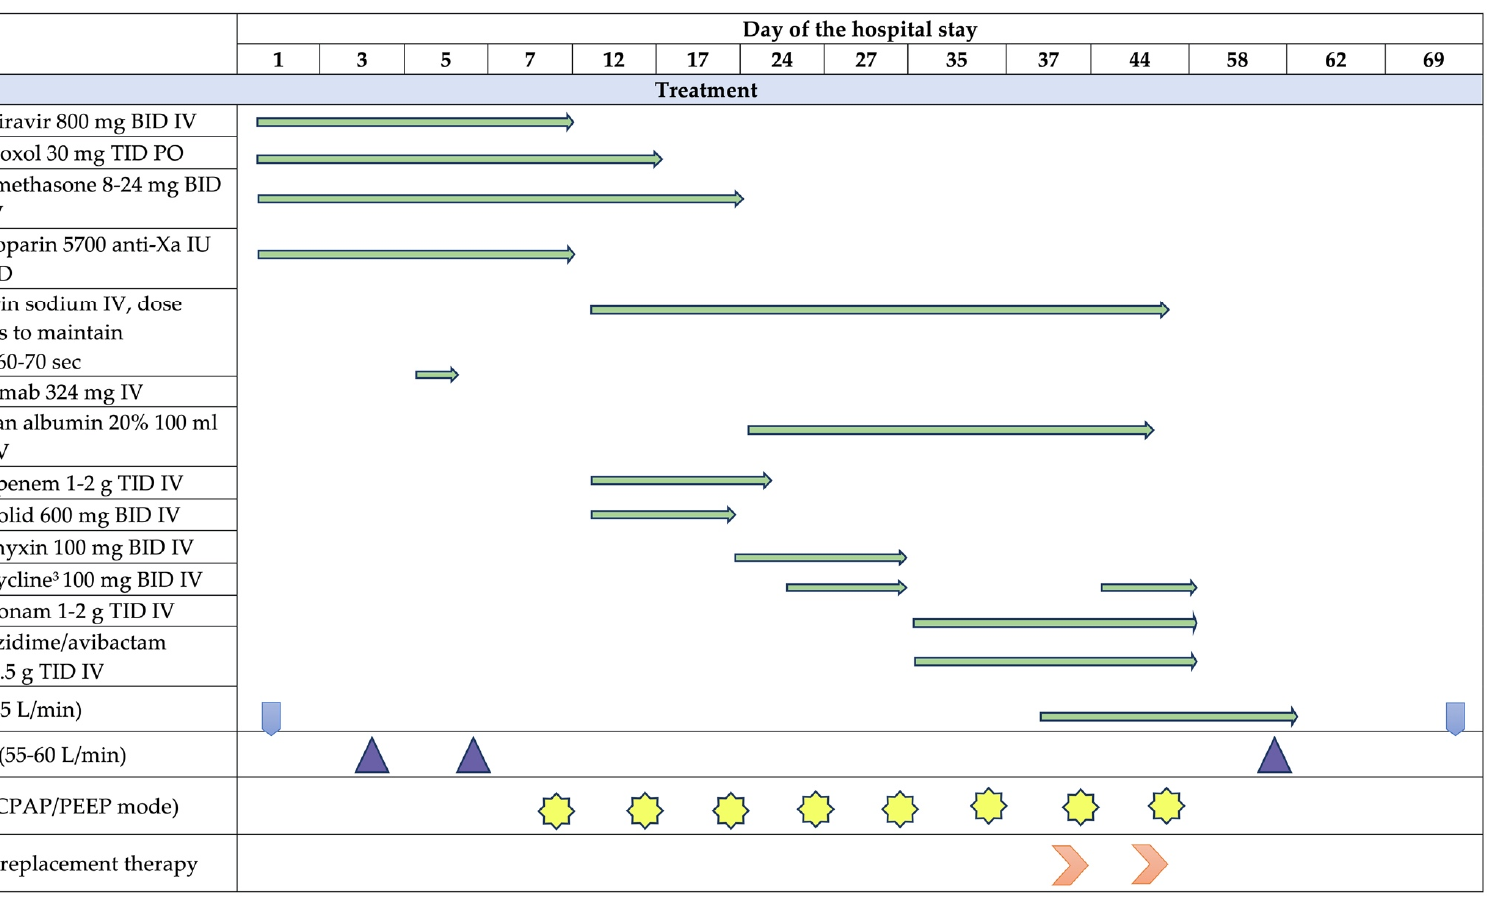
Figure 1. Clinical course of the disease in a 61-year-old male patient. 1 K.P.— K. pneumoniae ; 2 A.B.— A. baumannii ; 3 loading dose was 200 mg; WBC—white blood cells, HBG—hemoglobin, CRP—C-reactive protein, PCT—procalcitonin, PLT—platelets, LDG—lactate dehydrogenase, CT—computer tomography, TID—three times per day, BID—two times per day, PO—orally, IV—intravenously, aPTT—activated partial thromboplastin time, LFO—low flow oxygen, HFO—high flow oxygen, NIV—non-invasive ventilation, SC—subcutaneously, IU—international units.